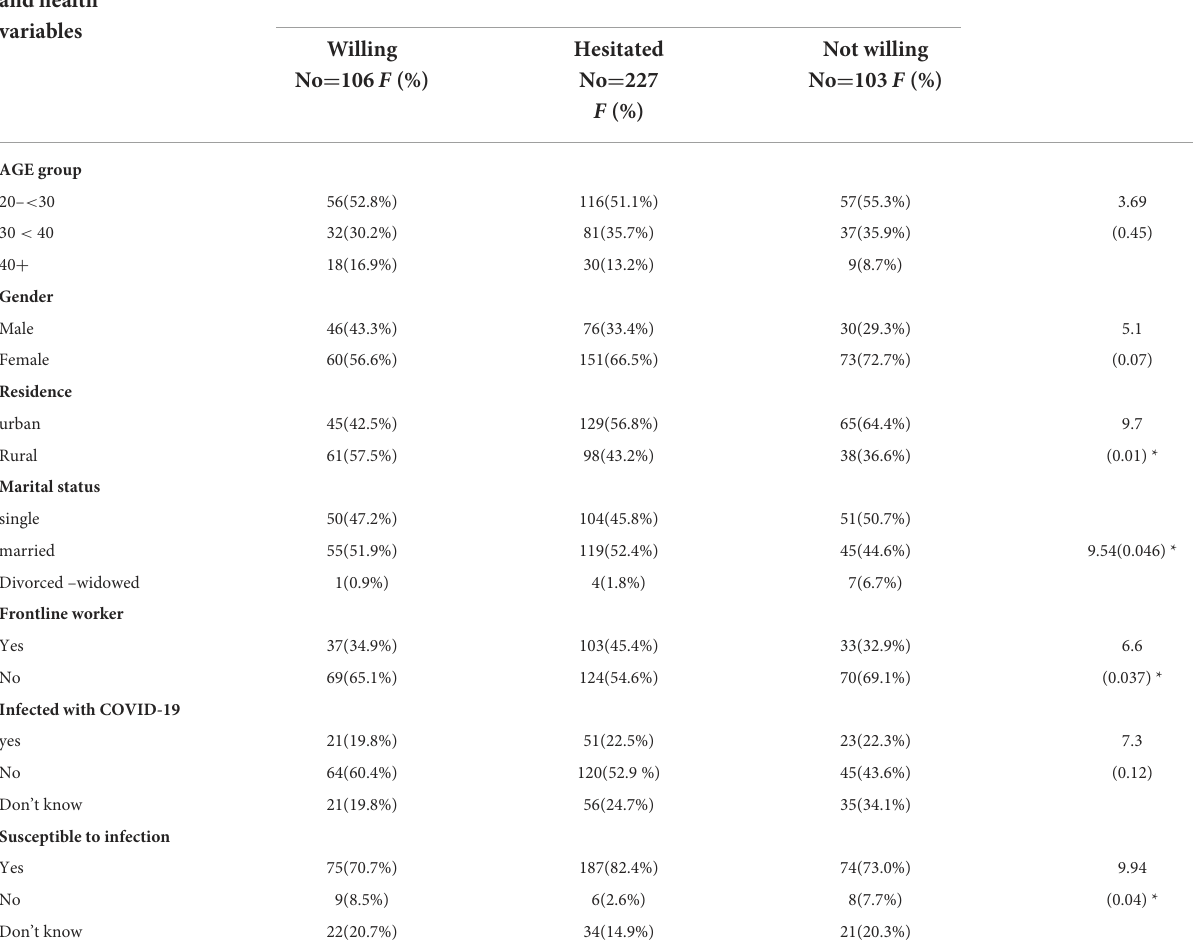
TABLE 4 Association between intentions toward COVID-19 vaccination uptake and some sociodemographic and health-related factors.